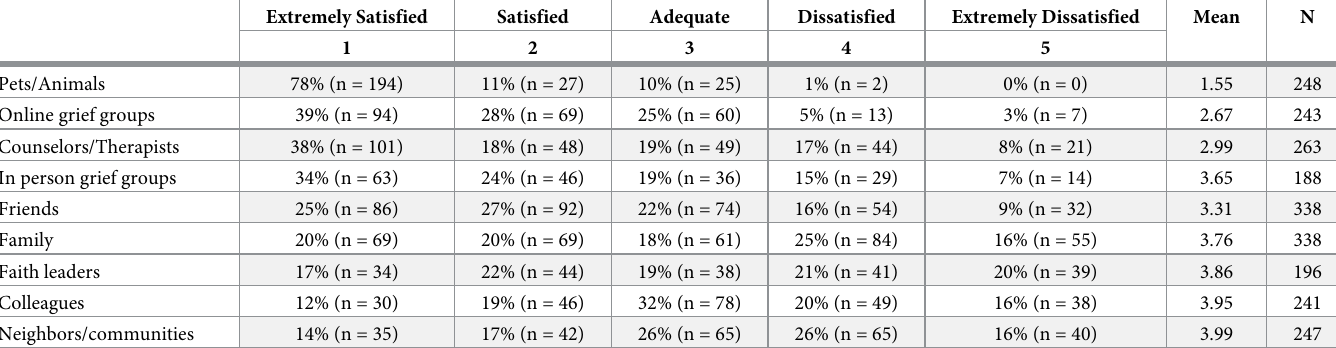
Table 2. Satisfaction with overall grief